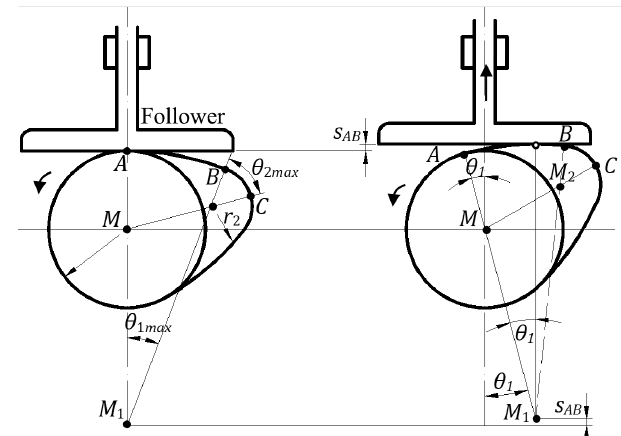
Figure 2. Follower movement on arc-AB.